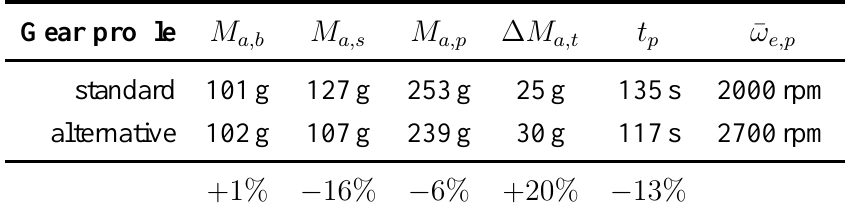
Table 5. Cumulative air masses transferred in each mode on the aNEDC for various gear